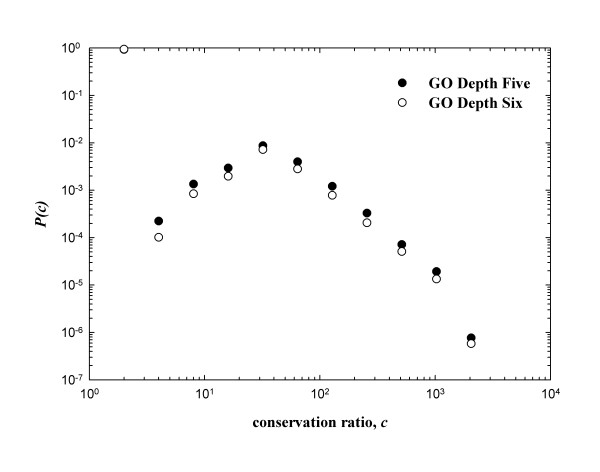
Distribution of the conservation ratio of the motif modes in the yeast PPI network. Distribution of the conservation ratio of motif modes shown on a log-log plot are marked as filled and open circles when the GO terms at depths five and six were employed, respectively.